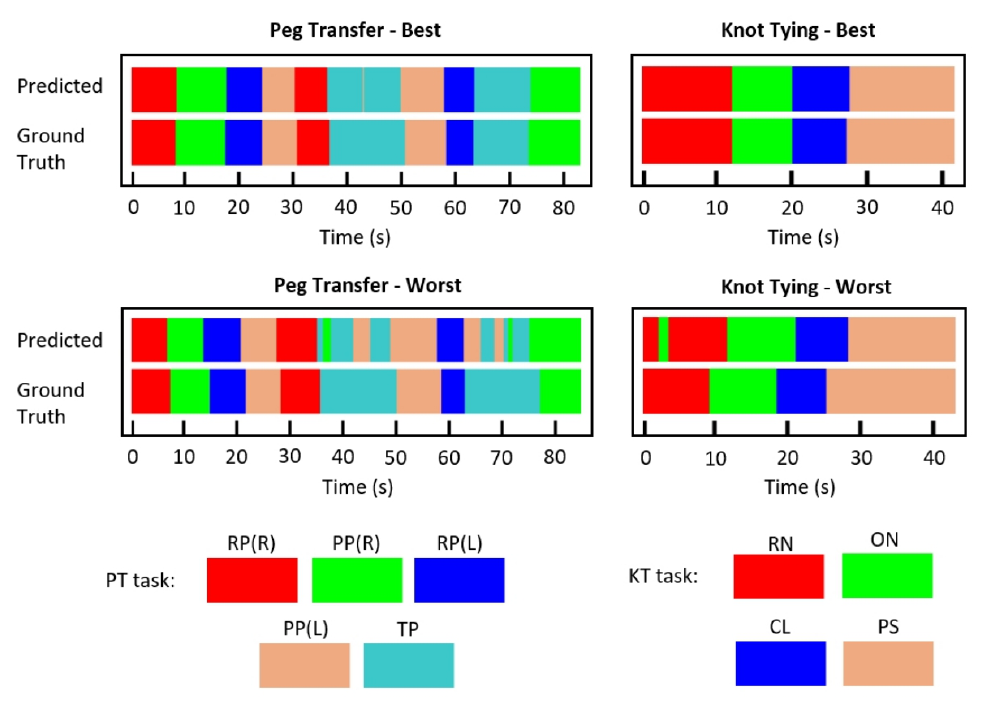
Figure 5. Color-coded ribbon visualization of the best and worst per-frame predictions, versus ground truth, for PT (left) and KT (right), using the C3DTrans-100